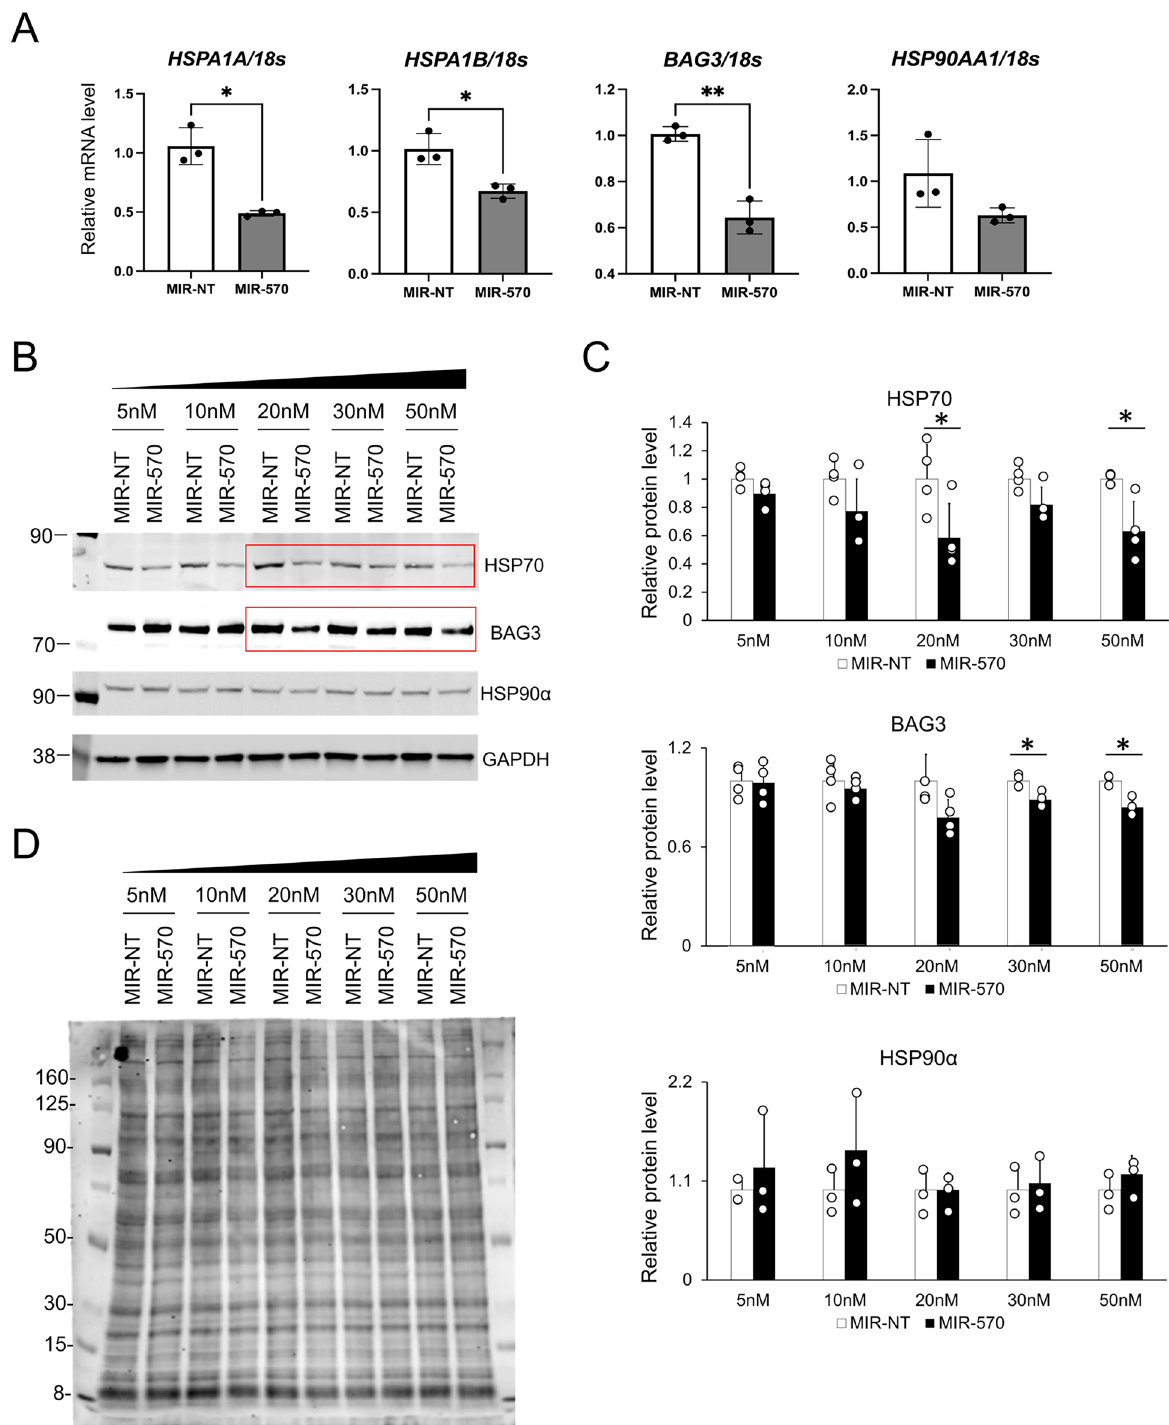
Figure 4. Characterization of HSP70, BAG3 and HSP90α as novel direct targets of miR-570. ( A ) Real-time qPCR analysis of HSPA1A , HSPA1B , BAG3 , HSP90AA1 in HEK293T cells 72 h after transfection with 25 nM (for BAG3 ) or 50 nM (for HSPA1A , HSPA1B and HSP90AA1 ) of dsRNA mimicking miR-570 (MIR-570) or control non-specific miRNA (MIR-NT). Representative image of two individual experiments with three replicates (n = 3; *p < 0.05, Student’s t-test, error bars = SD). ( B ) Western blot analysis of HSP70, BAG3, HSP90α and GAPDH in HEK293T cells 72 h after transfection with a range of concentrations, 5 nM to 50 nM, of miR-570 or miR-NT. Molecular weight markers are indicated in kilodalton. Original blots are presented in Supplementary Fig. S6. ( C ) Quantitative analyses of western blot for HSP70, BAG3 and HSP90α of three or four individual experiments. Individual data points are indicated by open circles. (*p < 0.05, Student’s t-test, error bars = SD). GAPDH was used as an internal control. ( D ) Total protein staining in HEK293T cells 72 h after transfection with 5 nM to 50 nM of miR-570 or control non-targeting miRNA of three individual experiments. The amount of protein sample was loaded 5 μg per each lane. Molecular weight markers are indicated in